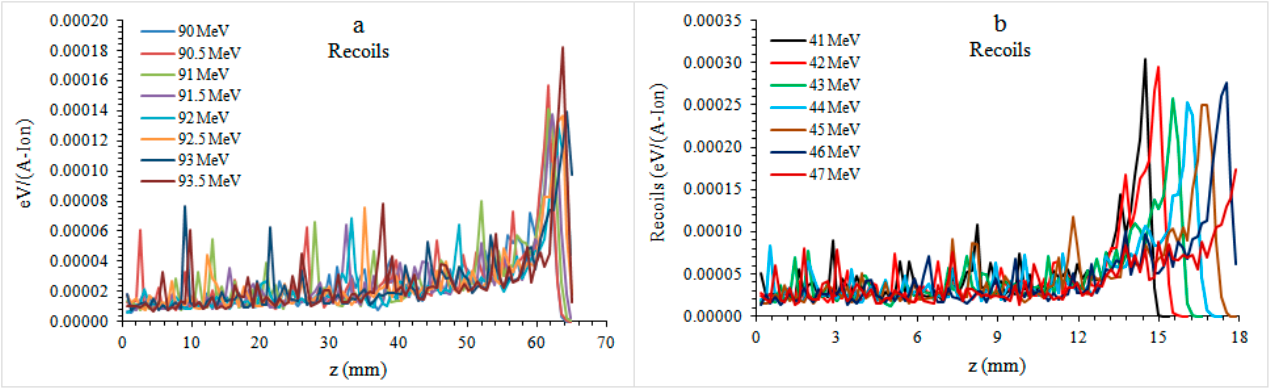
Figure 5. Recoils curves of different energy proton beams in tooth plate molar ( a ) and premolar ( b ) phantoms.